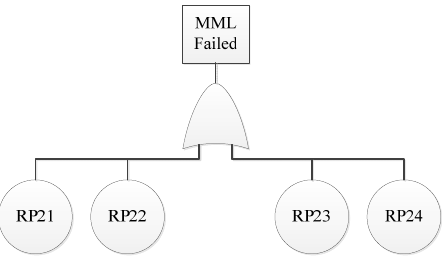
Figure 5. Configuration reliability fault tree model of the KTV phase.